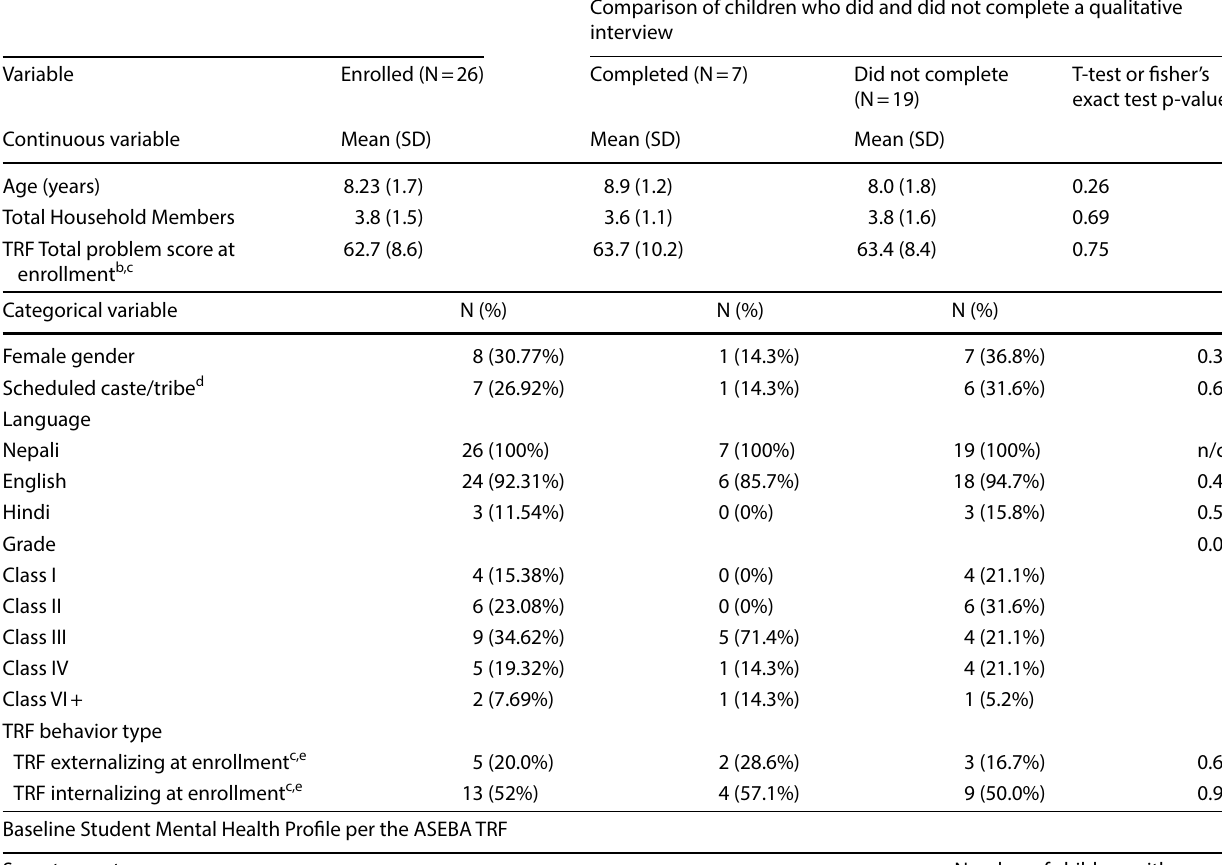
Table 3 Child demographics and comparison of children who did and did not complete a qualitative interview